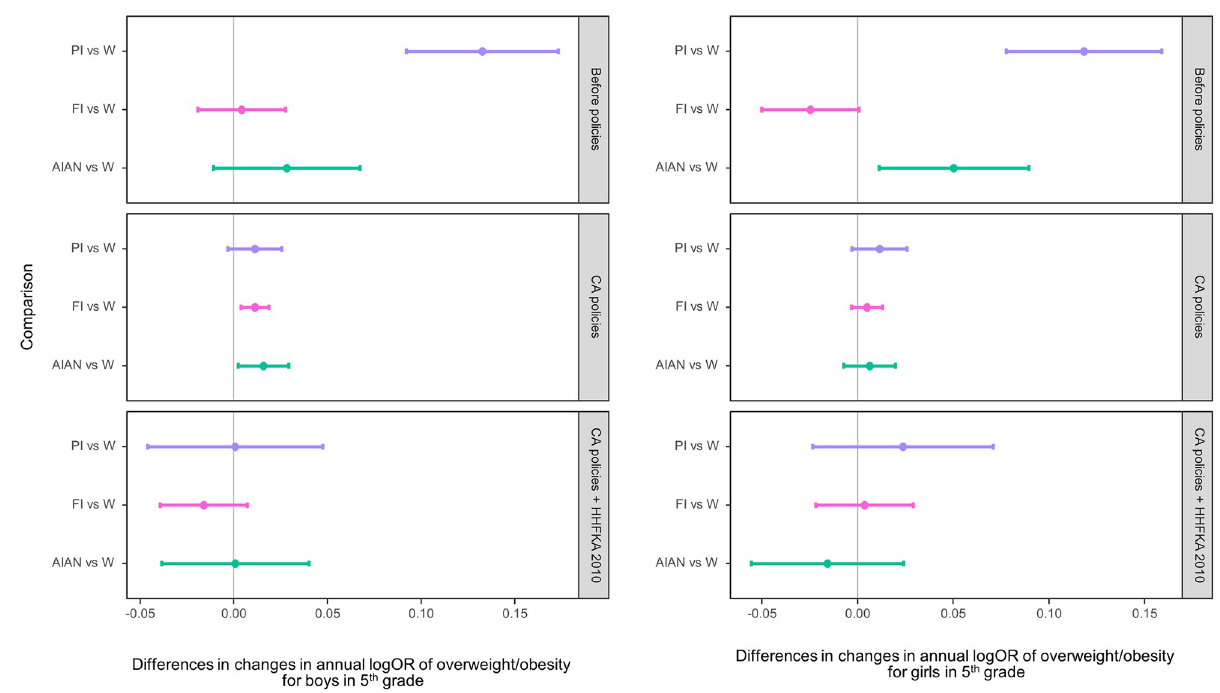
Fig 4. Racial/ethnic differences in adjusted changes in the log odds of overweight/obesity per year comparing the periods 2002–2004 (baseline, no policies in effect), 2005–2012 (after CA policies and before HHFKA 2010), and 2013–2016 (CA policies plus HHFKA 2010) among fifth graders by sex. The dots indicate the point estimates of the yearly changes in the log odds, and the whiskers show the 95% confidence intervals. AIAN, American Indian/Alaska Native; CA, California; FI, children of Filipino origin; HHFKA 2010, Healthy, Hunger-Free Kids Act of 2010; OR, odds ratio; PI, children of Pacific Islander origin; W,